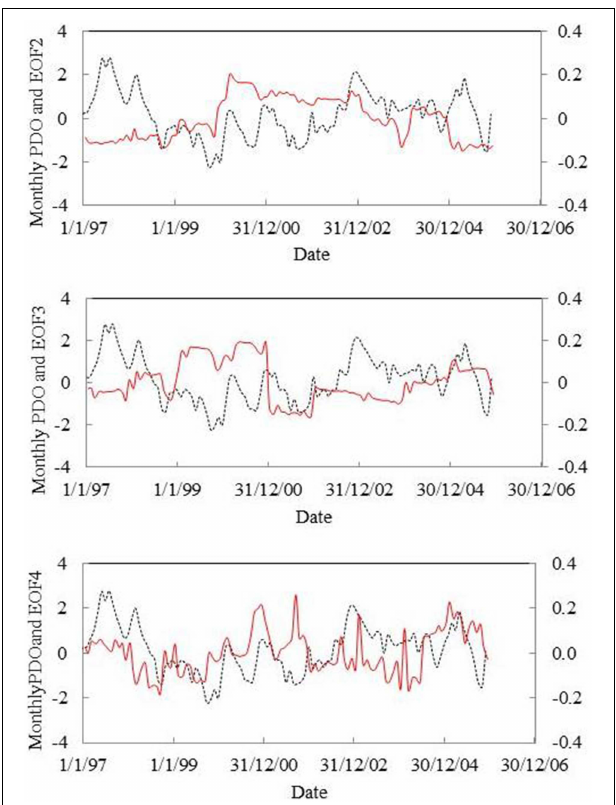
FIGURE 13 | Comparison of temporal eigenfunctions and SOI. Primary axis corresponds to temporal EOFs. Secondary axis corresponds to monthly SOI. Red lines—temporal EOFs, black dotted lines—monthly SOI.